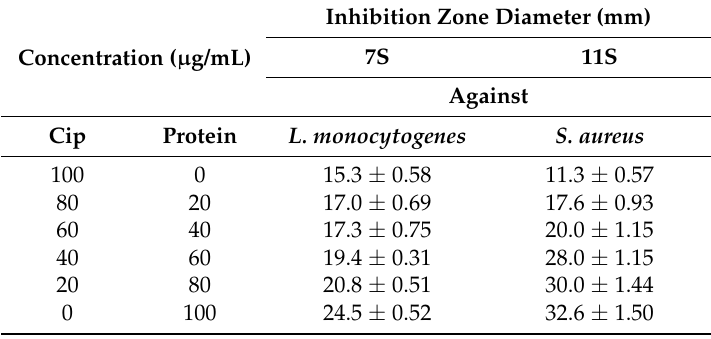
Table 2. Antibacterial activity against L. monocytogenes and S. aureus using combinations of antibiotic (Cip.) and both of 7S and 11S globulin, as assessed by disc diffusion assay.